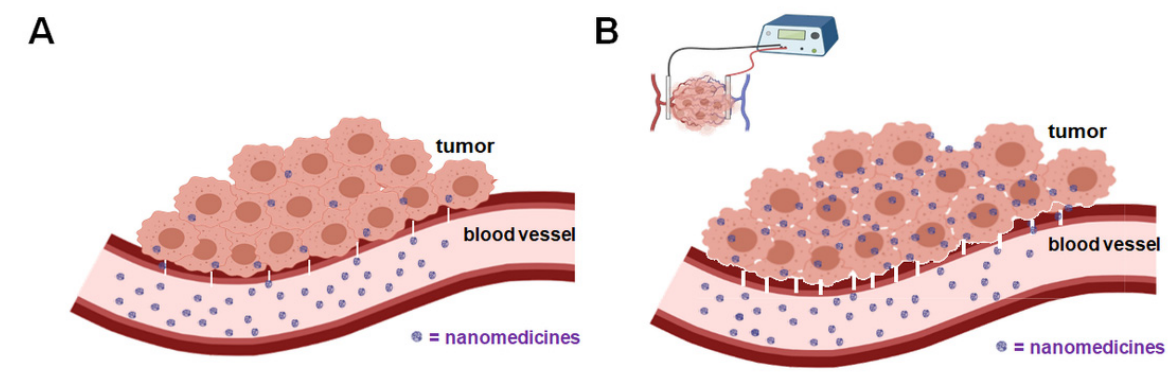
Figure 5. ( A ) Nanomedicine and EPR effect; ( B ) nanomedicine and EPR-enhanced effect by application of electroporation. Electroporation combined with the local administration of nanomedicines is worthy